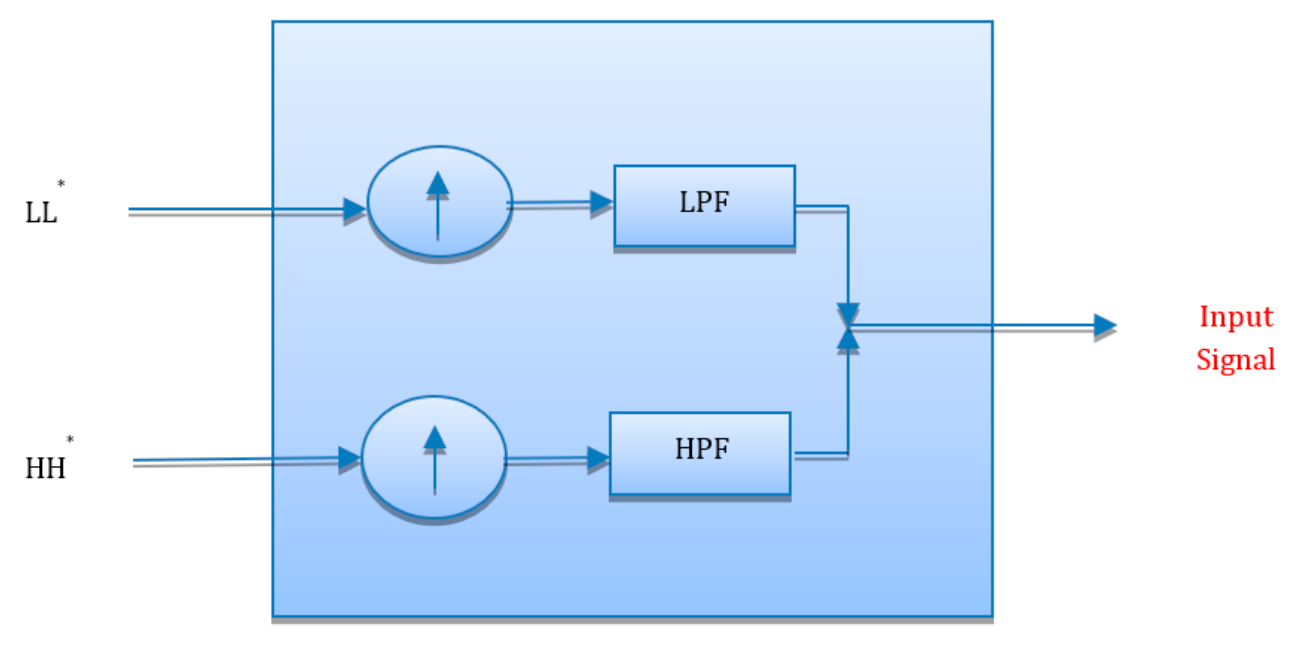
Figure 6. Signal Synthesis.